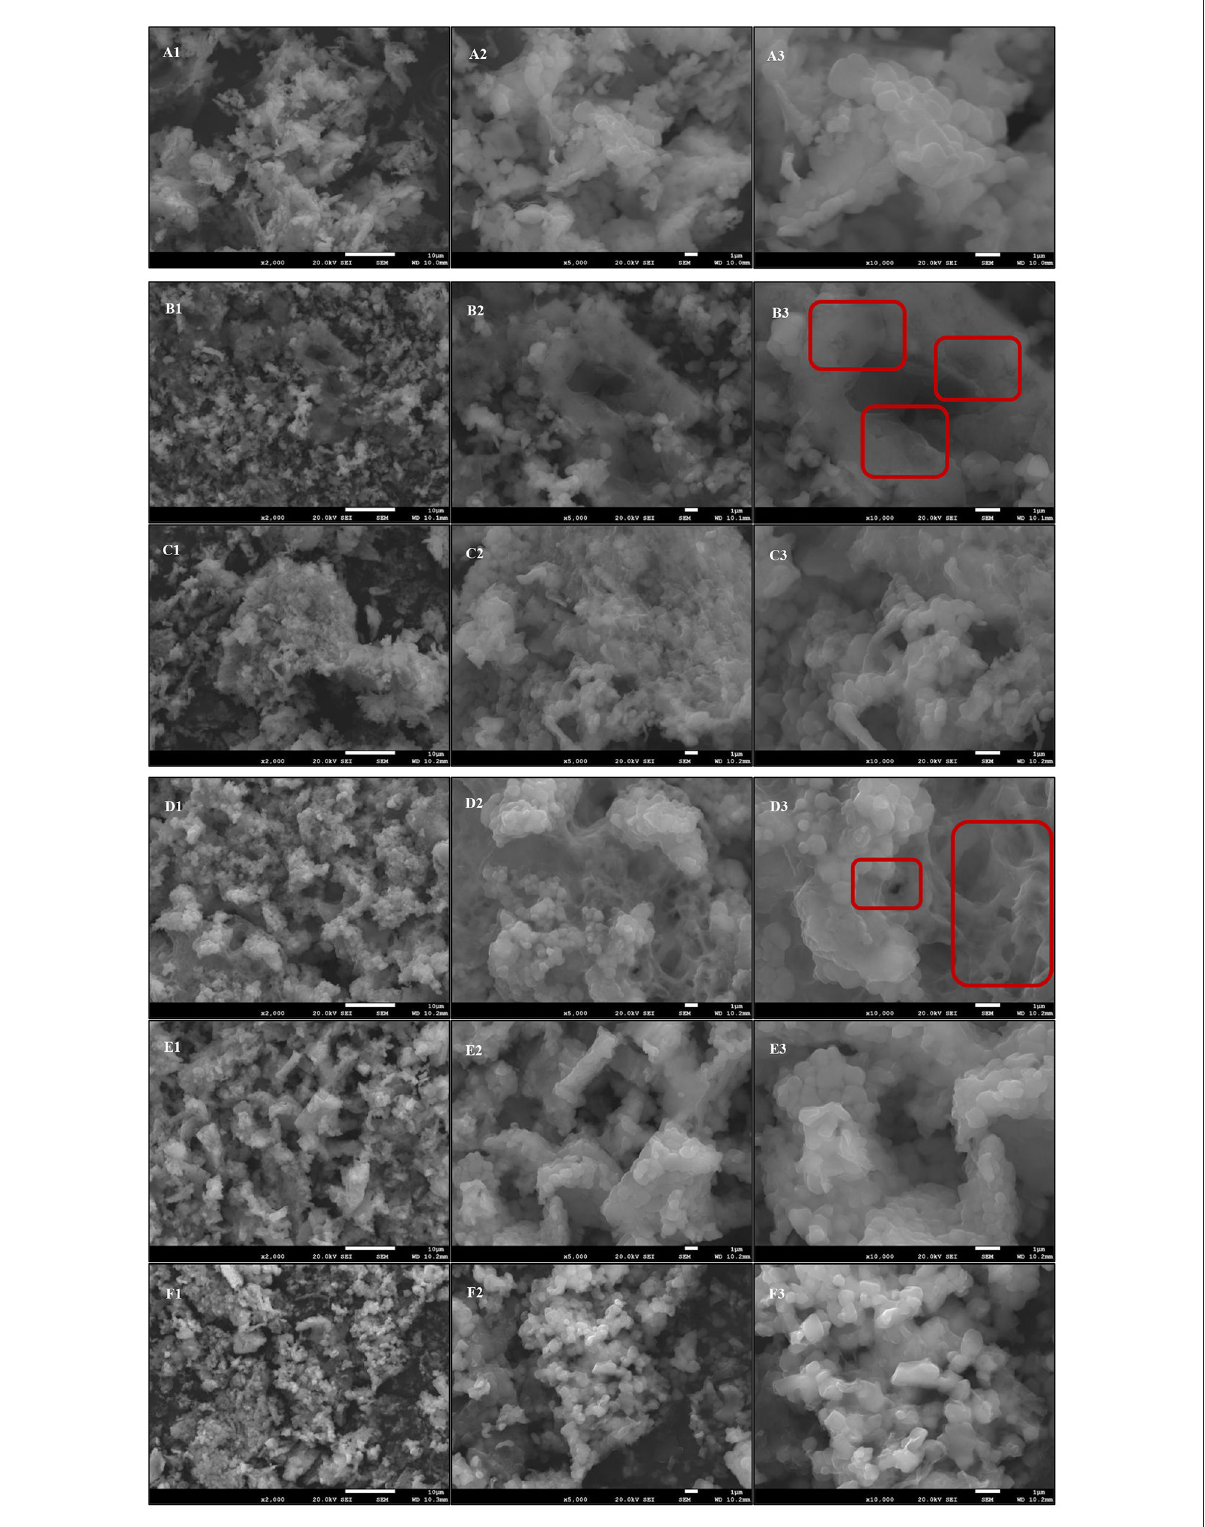
FIGURE11 Comparison of the microstructure of different oxidation incubation systems. (A) n-LDL; (B) ox-LDL; (C) BHT; (D) CEF; (E) PEF; (F) GNT. Numbers: 1, × 2,000; 2, × 5,000; 3, × 10,000.